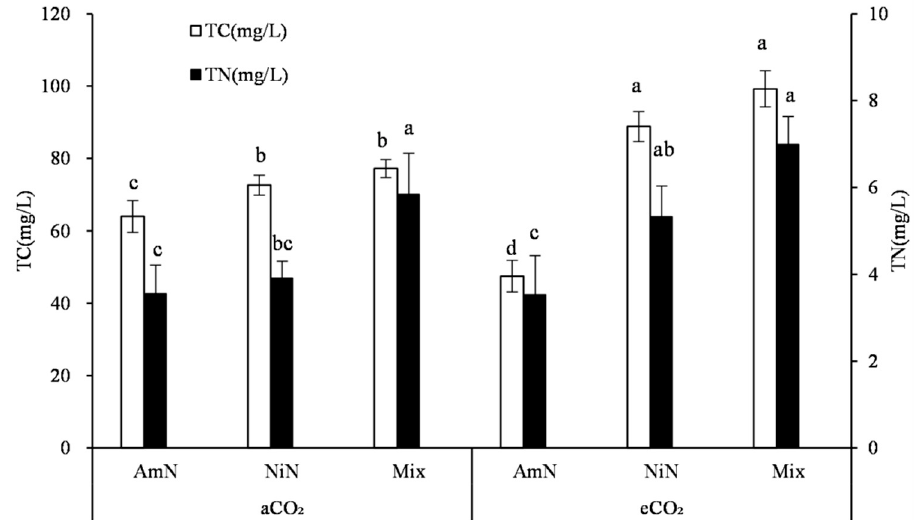
Figure 3. Carbon and nitrogen concentrations in the root exudates of wheat. Note: (1) AmN denotes Ammonium N, NiN denotes Nitrate N, Mix denotes Mixed N; (2) TC means total C concentration, TN means total N concentration; (3) aCO 2 denotes the ambient atmospheric CO 2 concentration at 390 µmol/mol; eCO 2 denotes the enriched atmospheric CO 2 concentration at 690 µmol/mol; (4) Different letters mean significant differences at p < 0.05 level for each indice; (5) error bars are standard deviation; (6) Statistical analyses for TC and TN LSD are conducted separately. Table 6. Two − factor ANOVA analyses for indices in the root exudate of wheat. Wheat